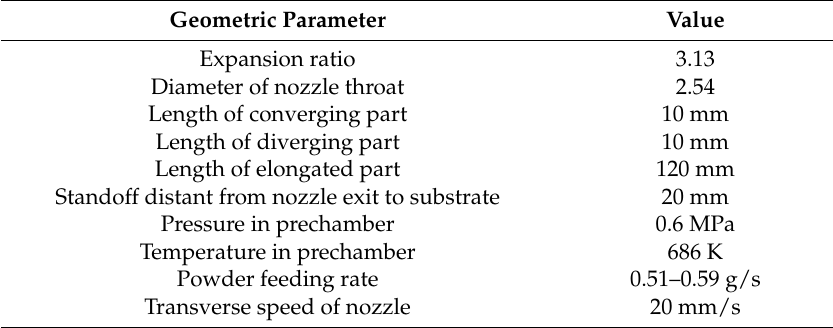
Figure 4. Photograph of equipment of low-pressure cold spray system Dymet 413 and its nozzle structure. Table 1. Summary of geometric parameters and working conditions of DYMET 413 used for preparing AlZn composite coatings.